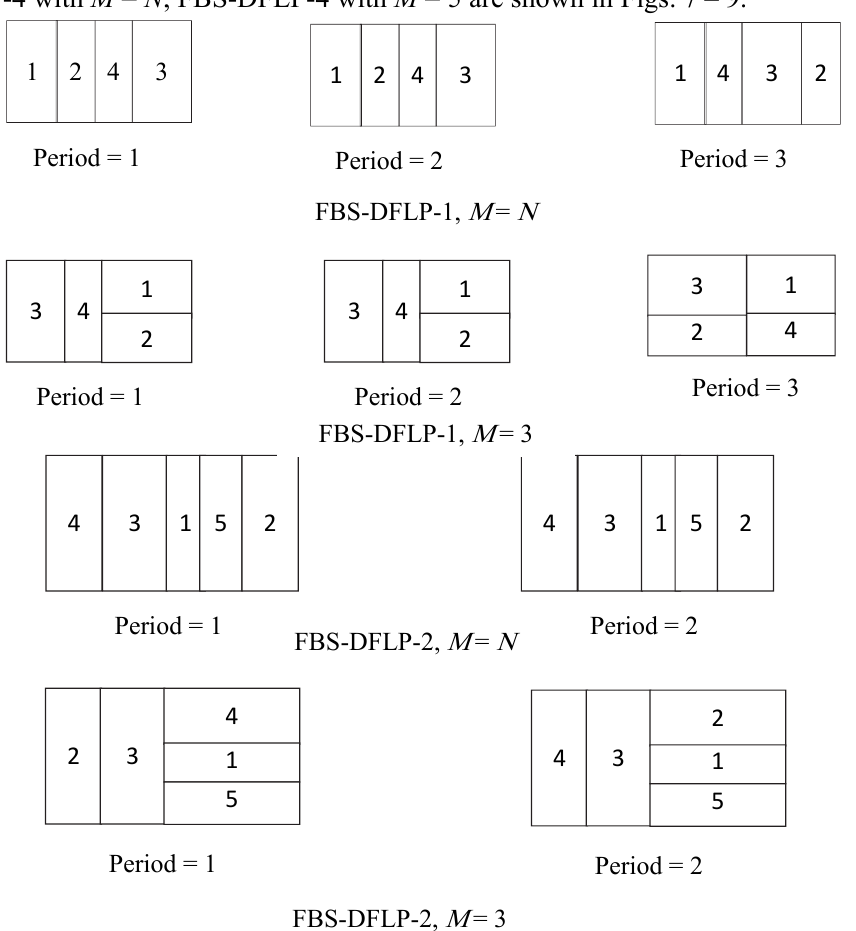
Fig. 7. Best layouts found for FBS-DFLP-1 with M = N , FBS-DFLP-1 with M = 3, FBS-DFLP-2 with